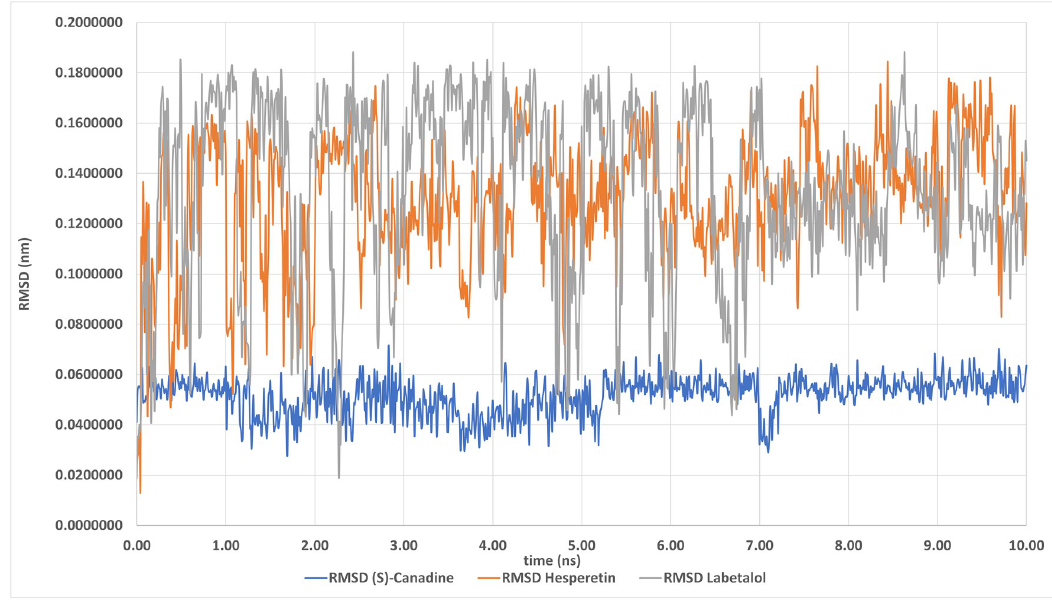
Fig 5. RMSD—Ligand heavy atoms in time of